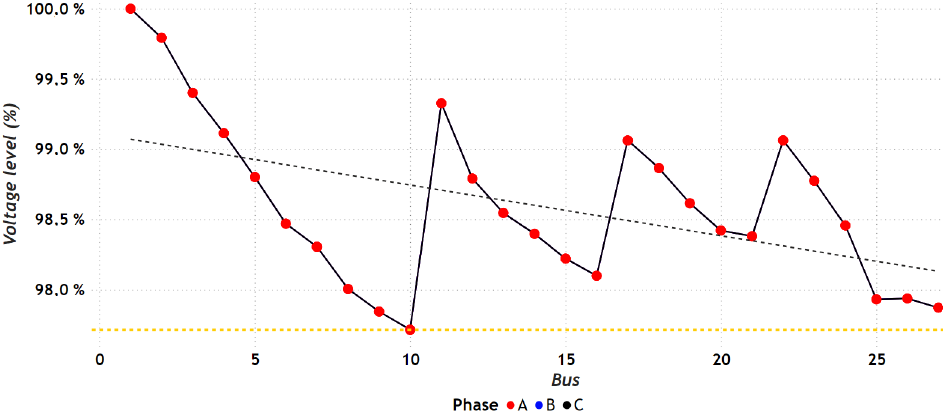
Figure 9. Behavior of the voltage profiles in the three-phase 27-bus distribution system under a balanced load scenario.